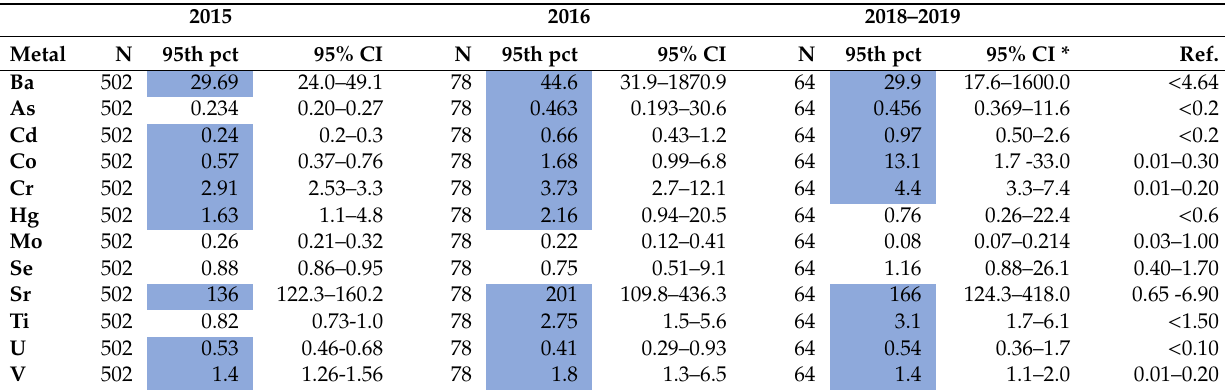
Table 4. 95th percentile values of metal concentration in ppm in the hair of Gaza mothers at delivery and in reference cohort outside war areas.